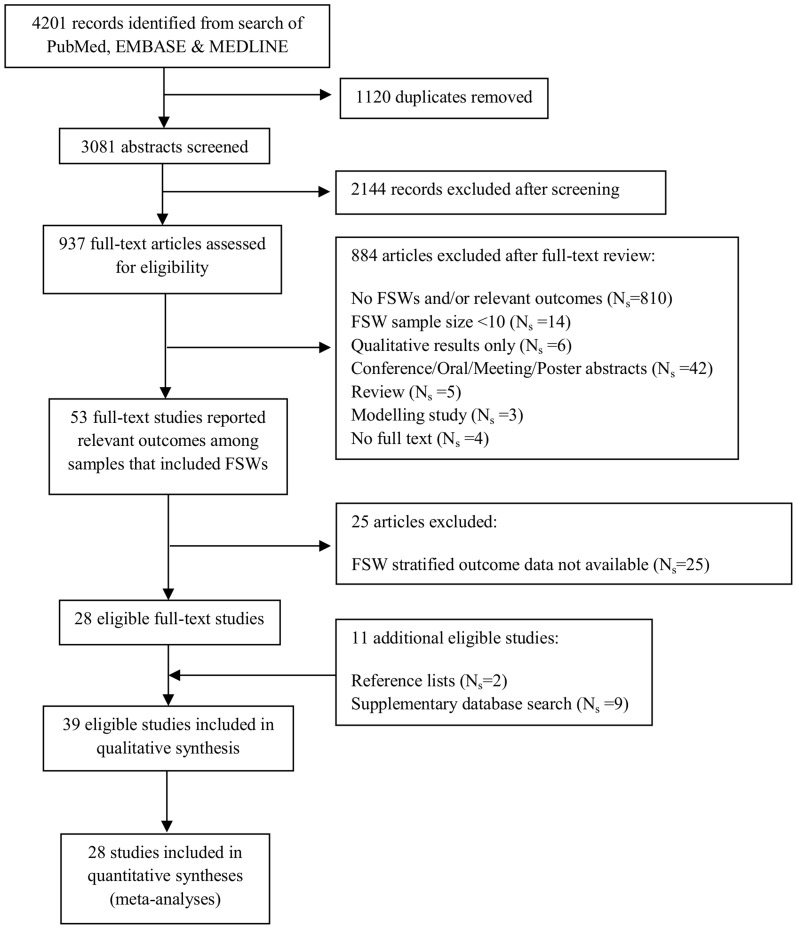
Flow diagram of search strategy and study selection process.FSW  =  female sex worker, ART  =  antiretroviral therapy, Ns =  number of studies.